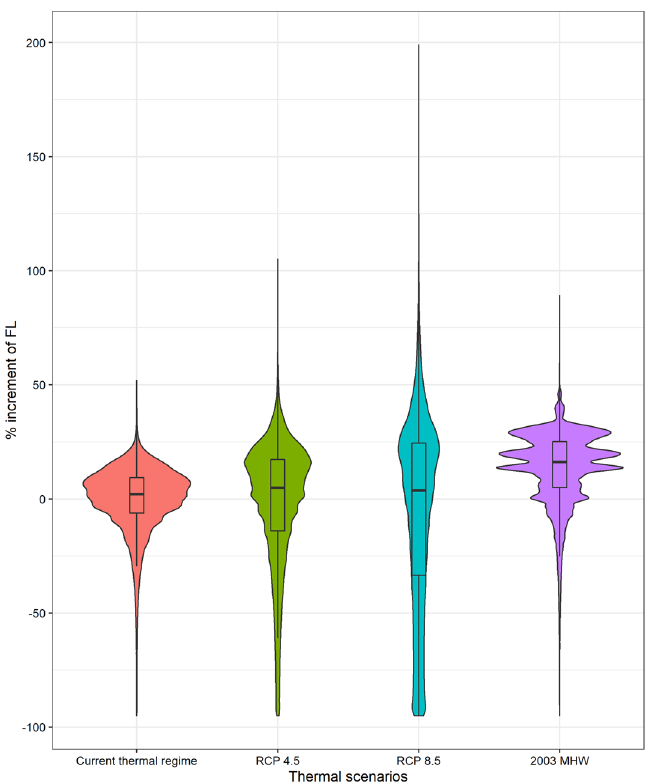
Figure 4. Violin plots (probability density) showing the percentage of increase in fish length (FL) with respect to the average fish length at catch under the current thermal regime (average 1995–2005) for projected thermal scenarios (RCP 4.5 and RCP 8.5 for 2080–2099) and the 2003 MHW. The evaluation date of the length distributions was the 15th of September in all cases. The boxplots represent the interquartile range and the horizontal black line corresponds to the median value of the correspondent distribution. Graph created with R 3.6.2 (https:// www.r- proje ct. org/) 24 using the ggplot2 package 25